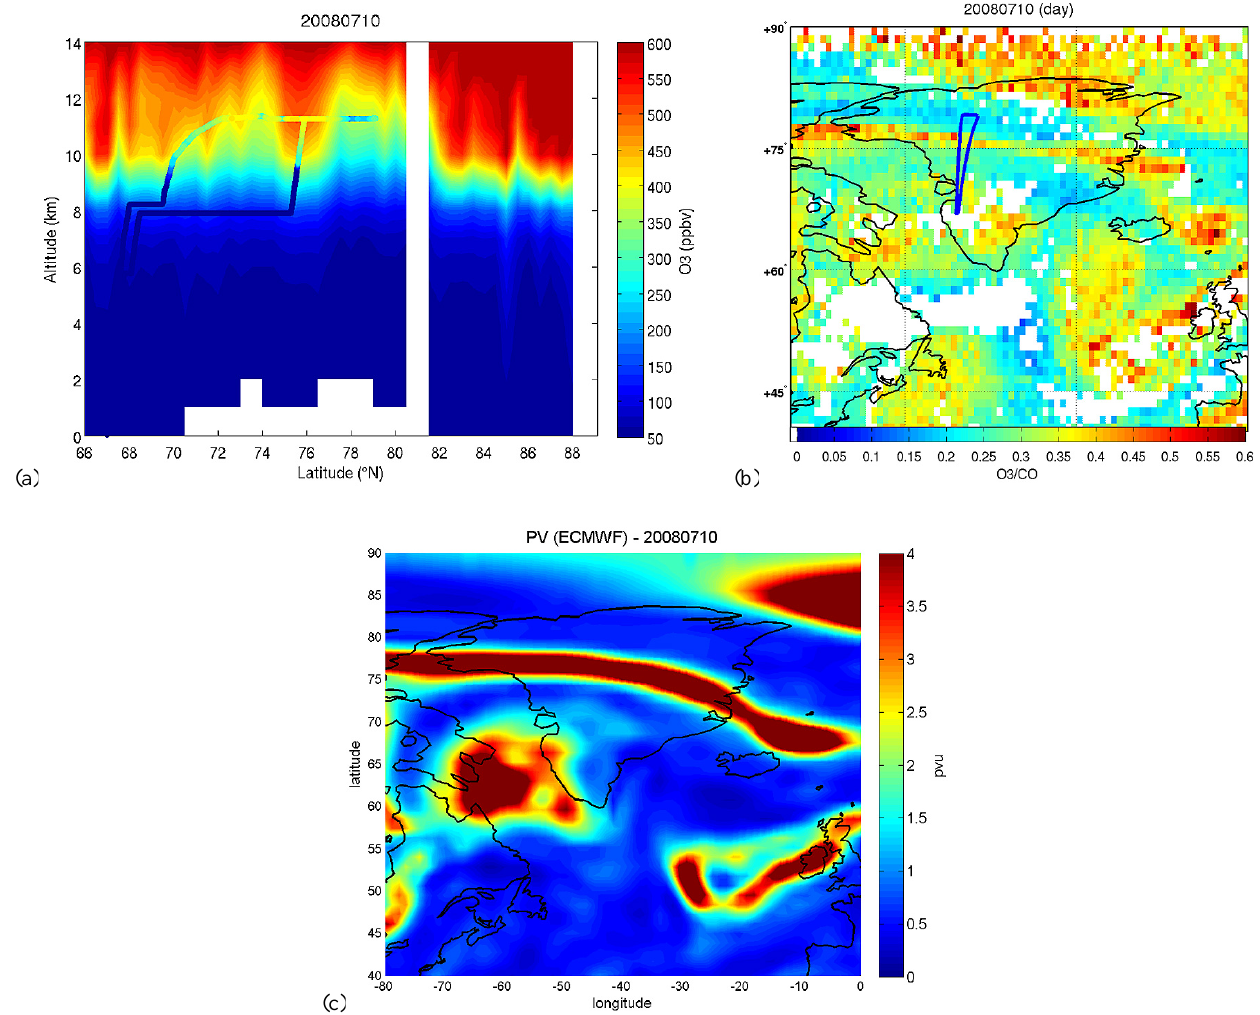
Fig. 11. (a) In situ O 3 volume mixing ratios (ppbv) measured by the Falcon-20 on 10 July 2008 compared to IASI O 3 vertical distributions along the flight. IASI data are averages data between 49 ◦ W and 51 ◦ W and sampled every 0.5 ◦ between 66 ◦ N and 89 ◦ N; (b) distributions of the ratio between daytime IASI O 3 [0–8km] partial columns and IASI CO total columns over Greenland on a 1 ◦ × 1 ◦ grid on 10 July 2008. The Falcon-20 flight track is plotted in blue. In (a) and (b) , white areas indicate no data; (c) potential vorticity (in PVU) at 8km over Greenland taken from an ECMWF analysis data at 12:00UTC on 10 July